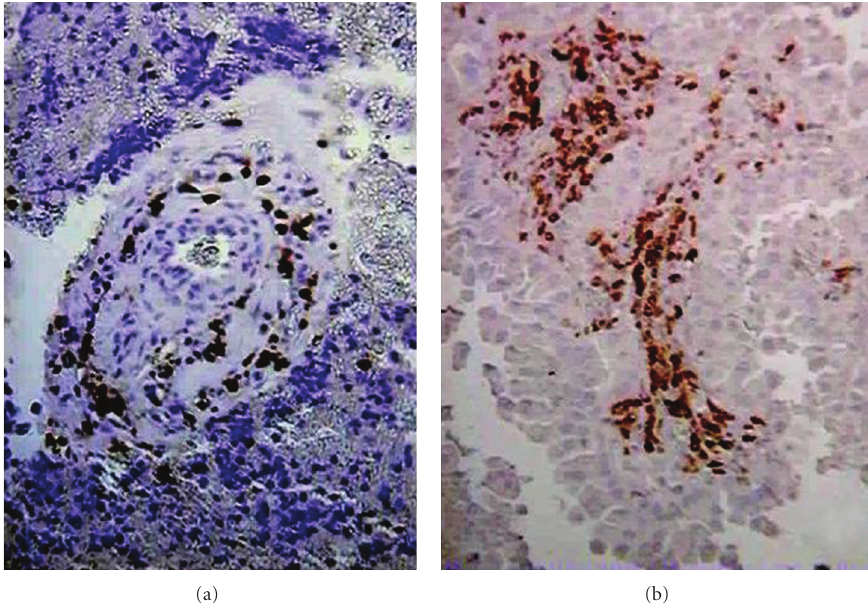
Figure 1: Examples of CD57 + NK-cells in the resected brain metastases of the series. NK-cells were generally distributed surrounding the vessels (a) and within the tumor stroma (b). Immunostained CD57 + NK-cells can be seen ( ×